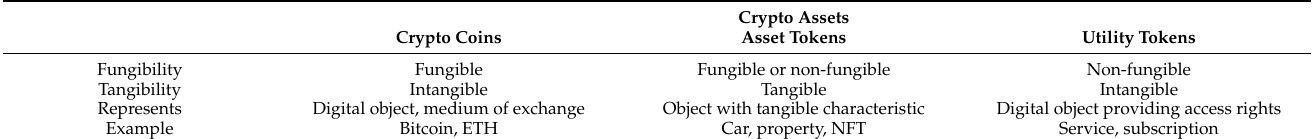
Table 2. Further explanation of crypto assets. Table modified from Pillai, Biswas and Muthukku- marasamy